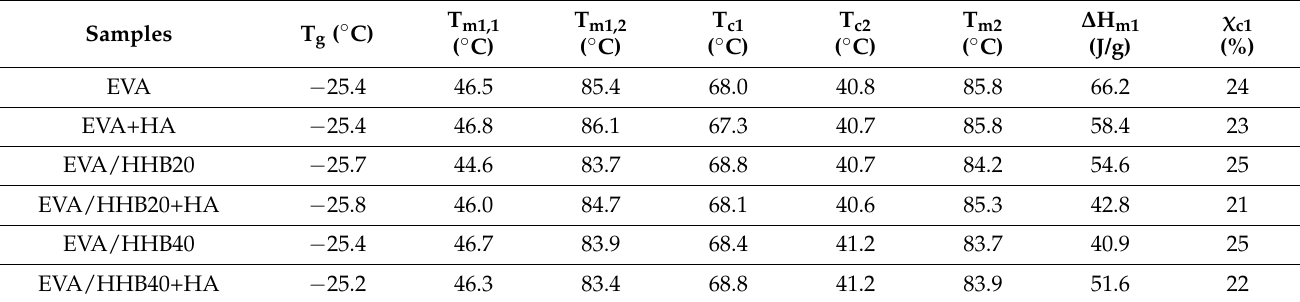
Table 1. Thermal parameters of EVA and its composites. (T g : glass transition temperature; T m1 : melting temperature of the first heating run; T c : crystallization temperature; T m2 : melting temperature of the second heating run; ∆ H m : Enthalpy of fusion; χ c: Crystallinity degree).